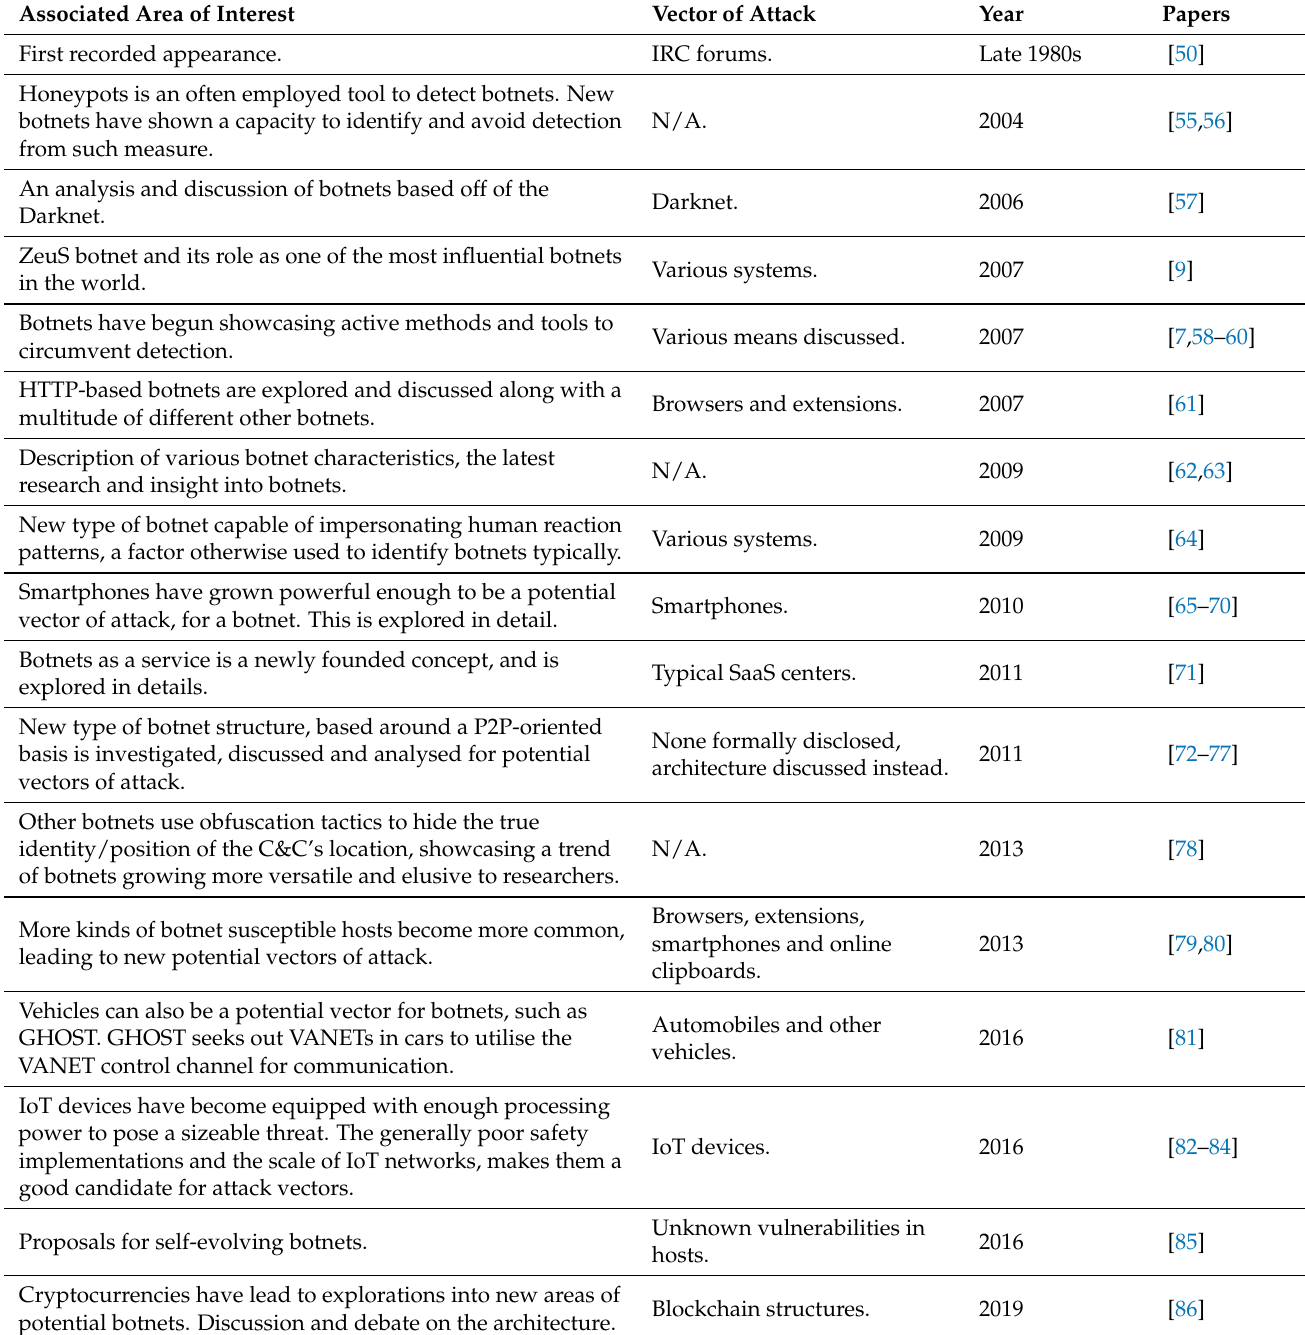
Table 3. Evolution of botnets and their associated papers. The first column describes the novelty and executive summary of the botnet evolution in question. The second and third columns explain the botnet attack vectors and the year of first mention. Lastly, the table lists the associated papers. Note: The papers listed is ordered by the year of the earliest documented occurrence of the described topic related to